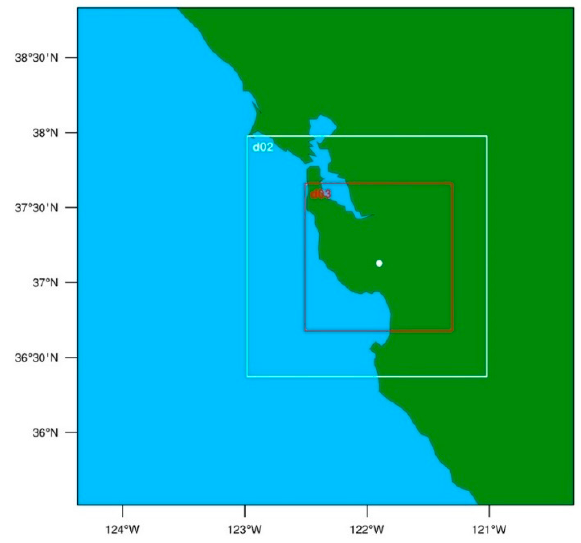
Figure 1. Weather Research and Forecasting (WRF) model domain setup. d02 = 1 km, d03 = 1/3 km. The white dot in the center of d03 depicts the location of the San Francisco Bay Area WSR-88D (KMUX). Table 1. WRF Microphysics Scheme Predicted Classes.